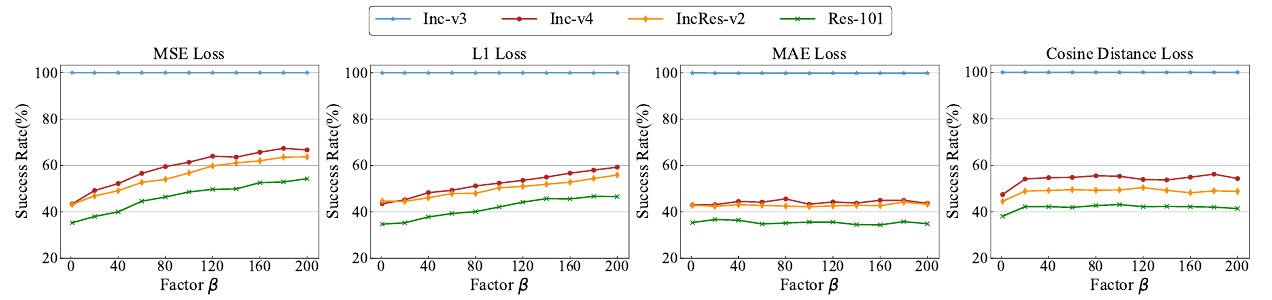
Figure 4. The success rate of different distance losses with the factor β from 0 to 200. The adversarial examples are crafted by Inception-v3 where the selected latent layer is the 6th